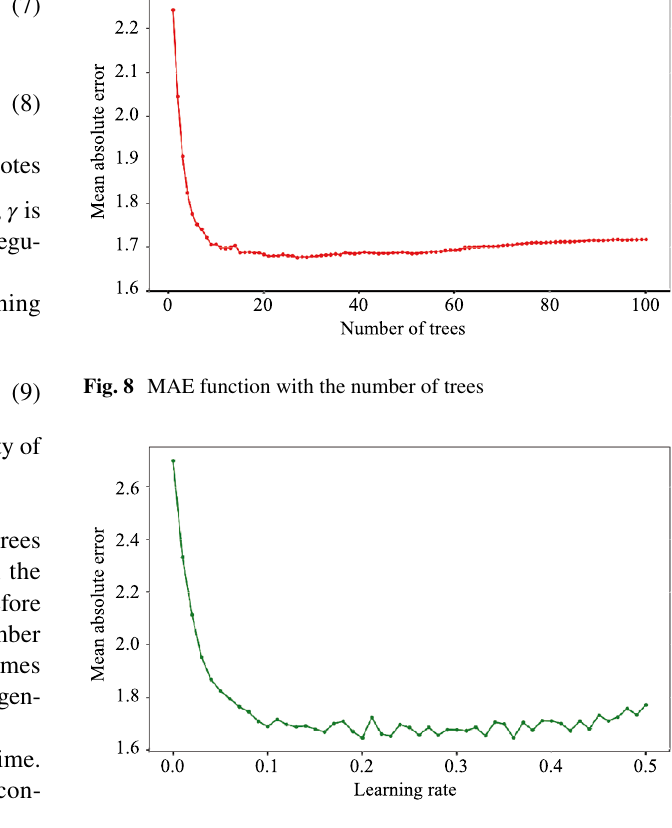
Fig. 9 MAE function with the learning